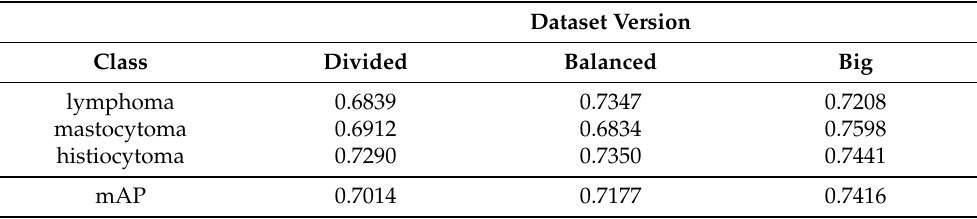
Table 5. Average precision for each class measured using testing subset of detection datasets.